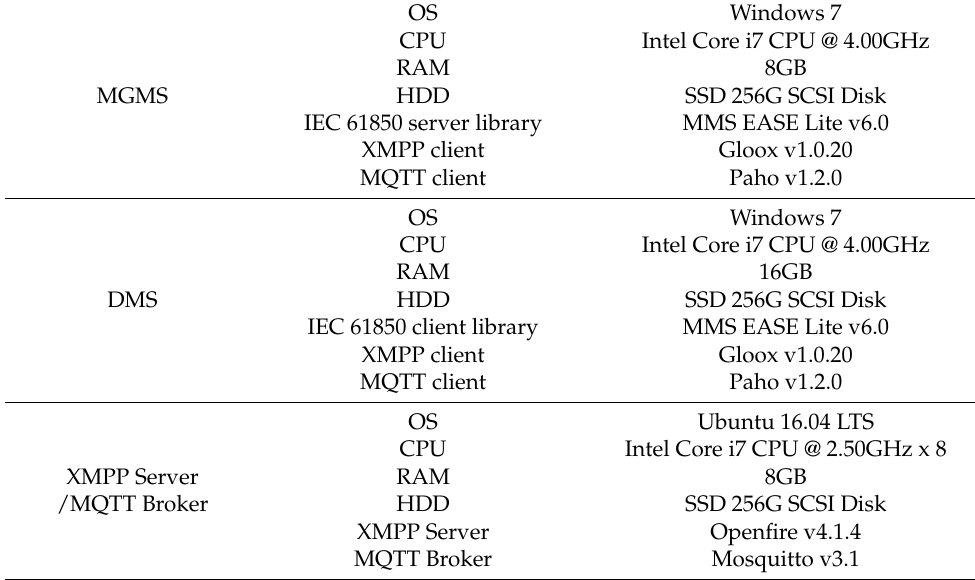
Table 2. Hardware specification for the test-bed.